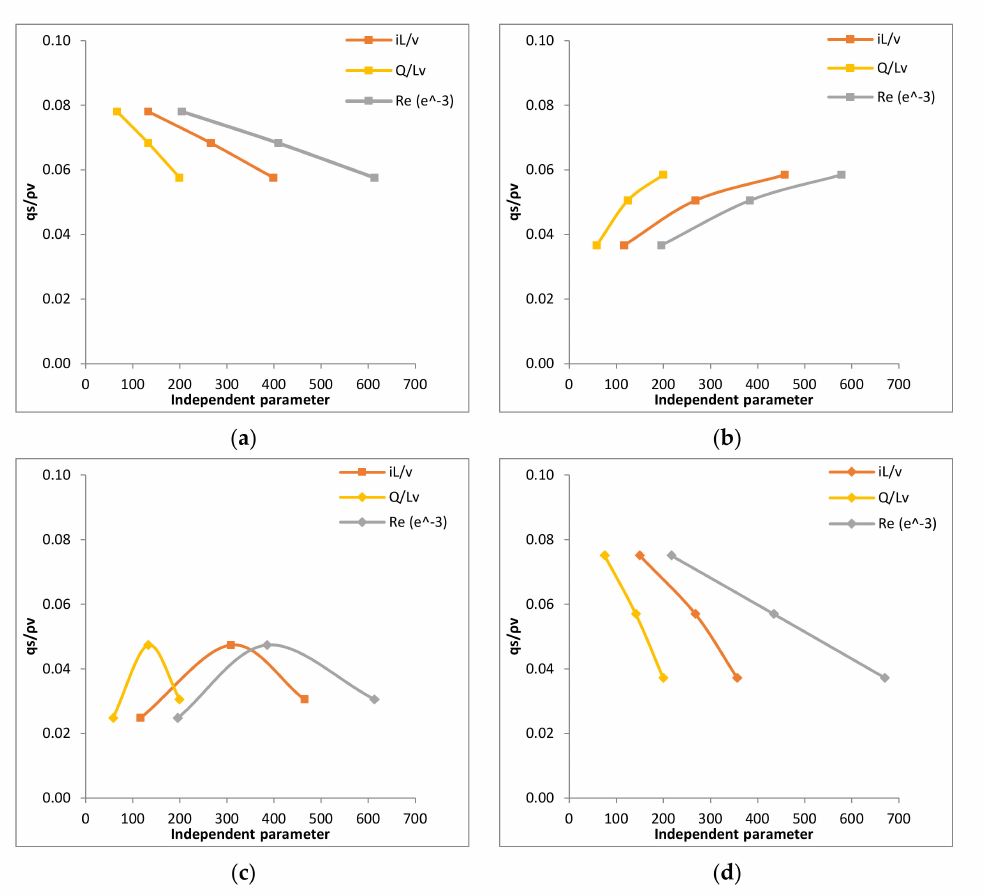
Figure 3. Relationship of dependent parameter, q s on different rainfall patterns: ( a ) CST-type; ( b ) ICR-type; ( c ) ICRDCR-type; ( d )